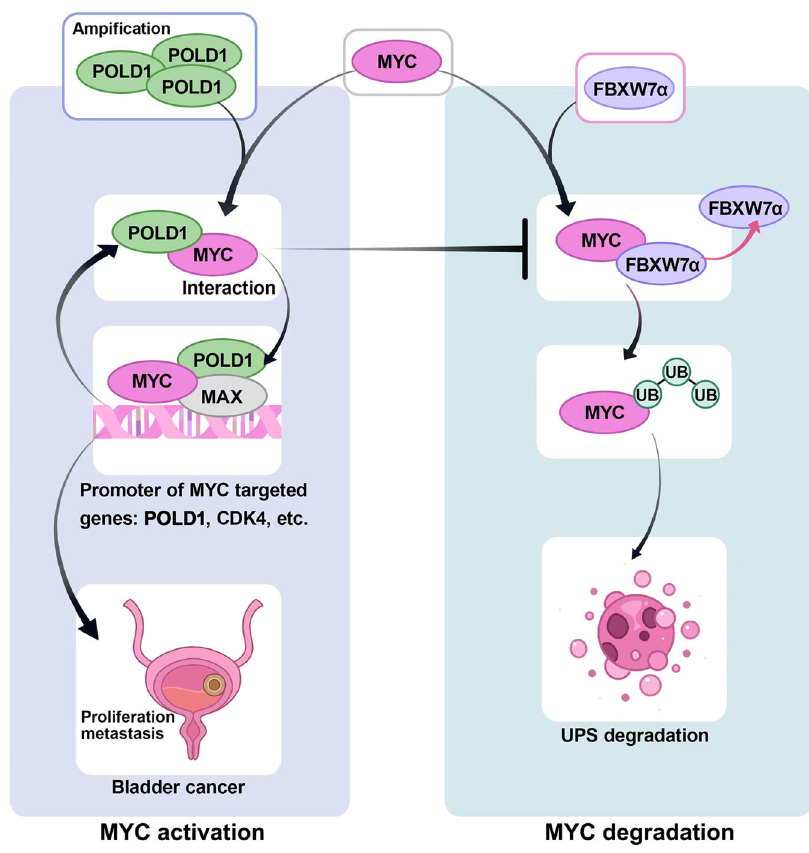
Fig. 8 | Mechanism diagram of this study. The schematic diagram illustrates the POLD1-MYCaxisdrivingtheproliferationandmetastasisofBLCA.InBLCA, POLD1 is upregulated due to ampli fi cation, MYC transcriptionalactivation and other causes. POLD1 competitively binds MYC with FBXW7 to reduce the ubiquitination degra- dation of MYC. Thus, POLD1 upregulates MYC and promotes the proliferation and metastasis of BLCA. At the transcriptional level, POLD1 can bind with MYC in the